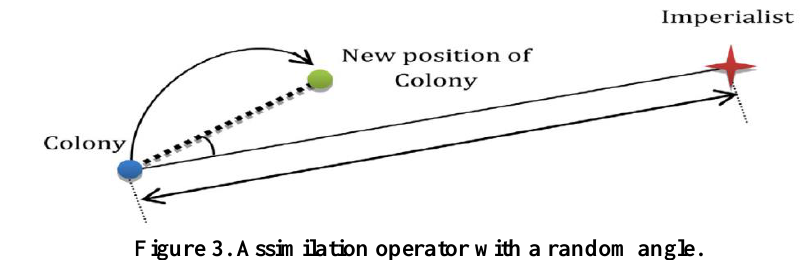
Figure 3. Assimilation operator with a random